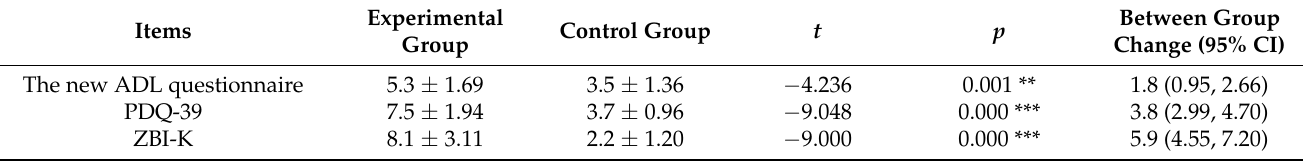
Table 4. Comparison of the experimental and control groups.